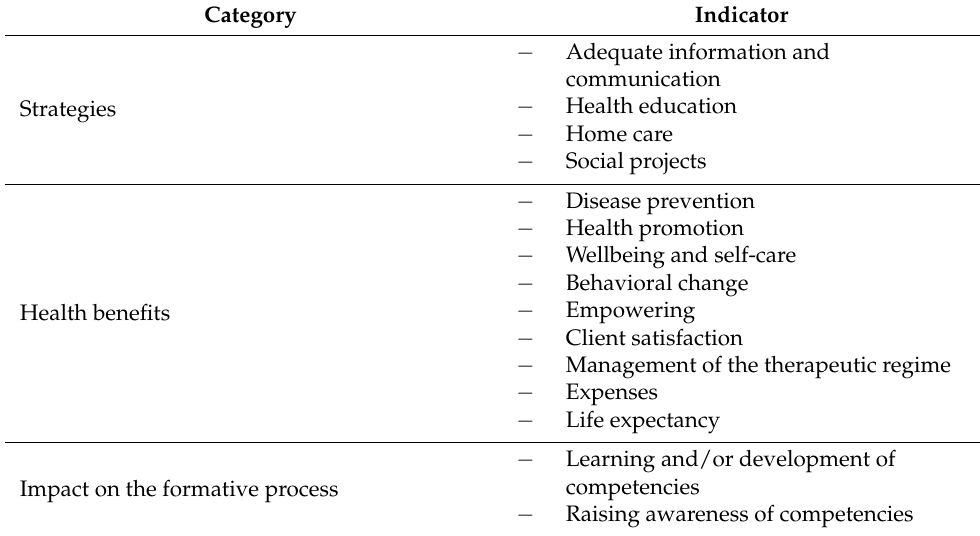
Table 1. Categories and indicators; Beja,